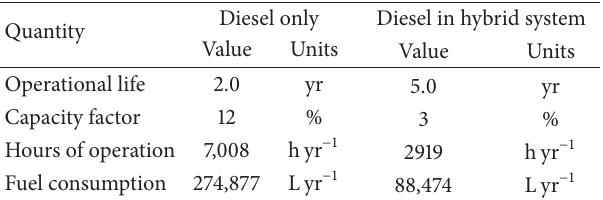
Figure 6: Cash flow analysis of NPC of existing diesel-only generator set [7].